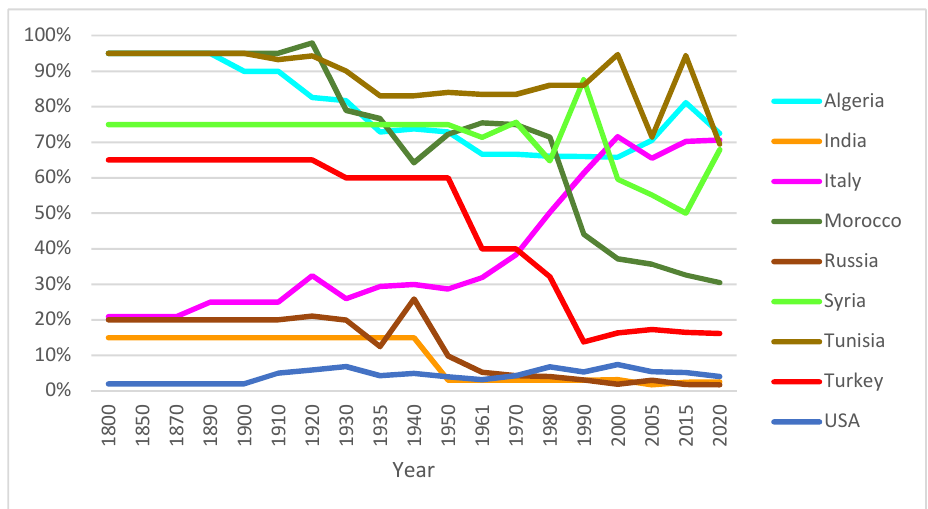
Figure 2. Historical durum wheat area (%) to all wheat area in the nine main durum wheat-growing countries in 1800–2020. Sources of information: [14,15,17,19,20,23,29–44,46,48,50].